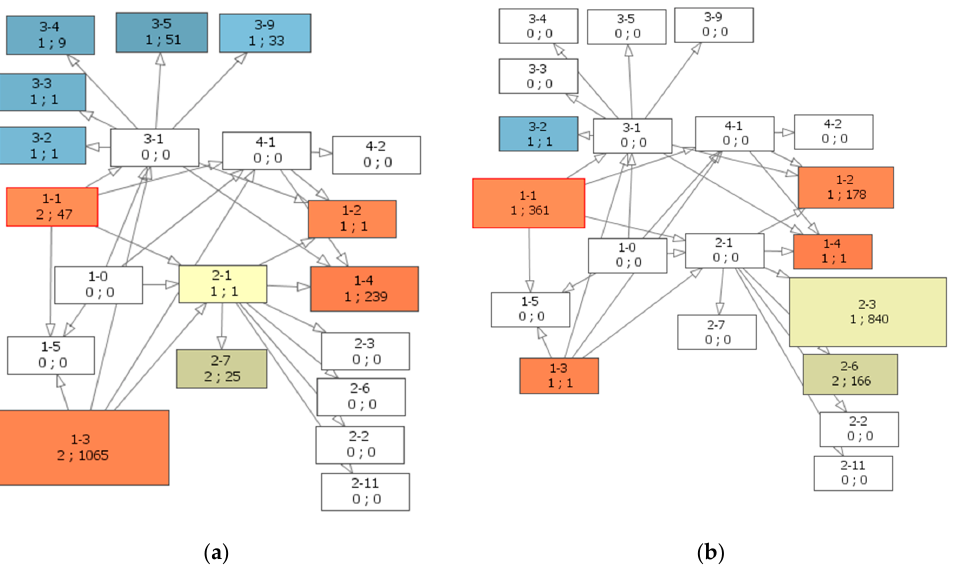
Figure 14. The graph of the zones visited by the employees of ( a ) IT department; ( b ) Managers department.